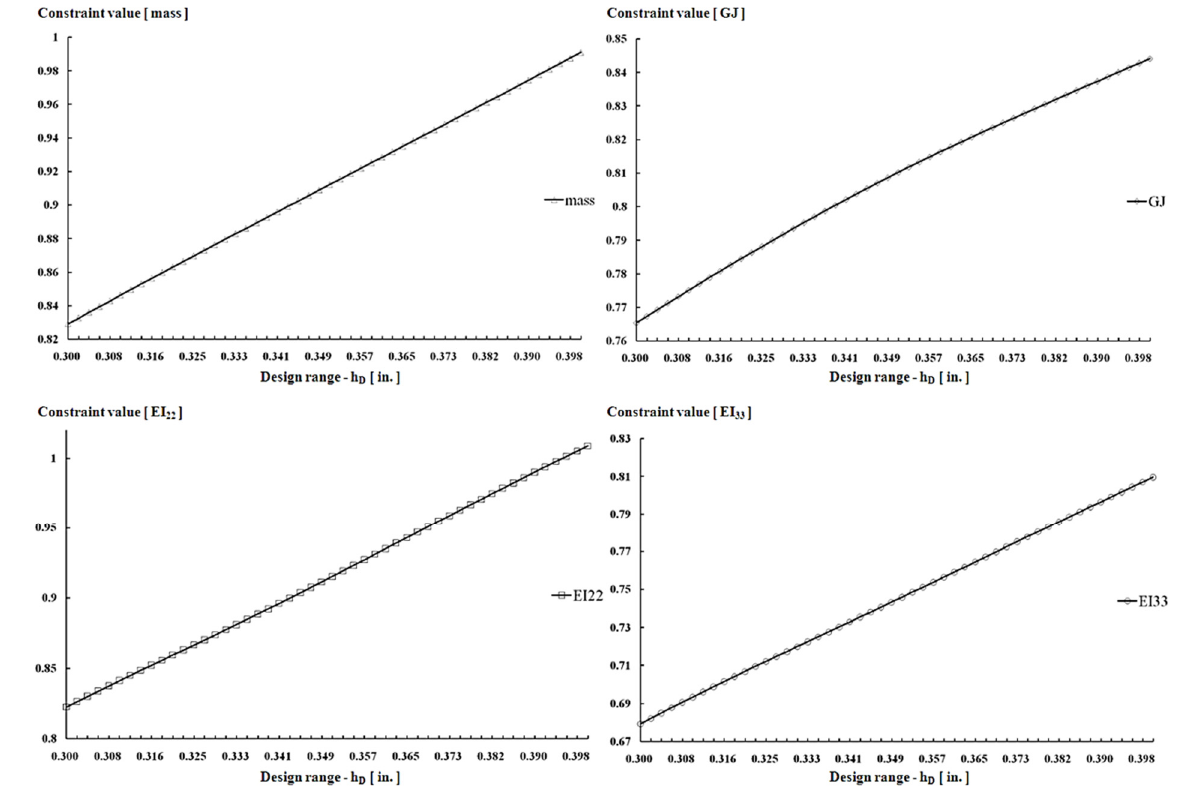
Figure 7. Meta-models for design variable—h D .